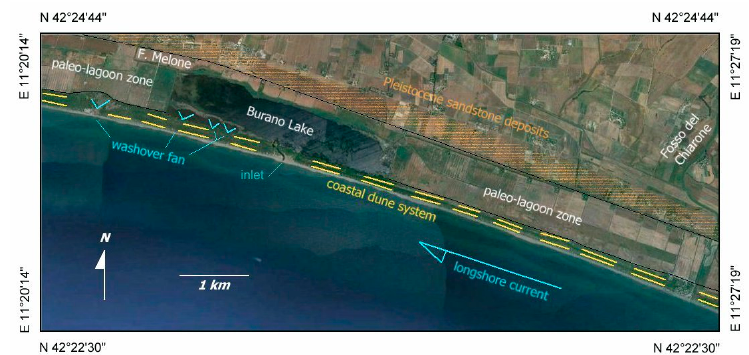
Figure 2. Geomorphological sketch map. The Fosso del Chiarone (river), which today flows into the sea, flowed into Lake Burano before the reclamation works. The washover fans indicate in the sketch are inactive today. From Google Earth image 2019. WGS84 Geographic Coordinate System are referred to the vertices.